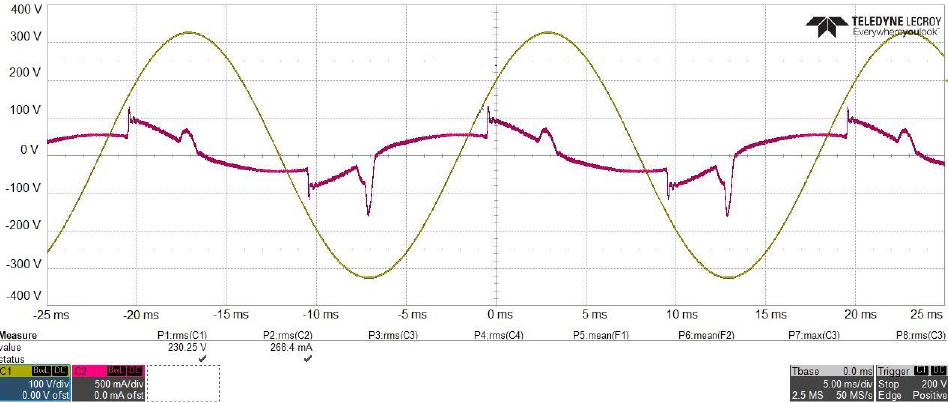
Figure 17. Voltage (C1, green) and current (C2, purple) of the mains in scan